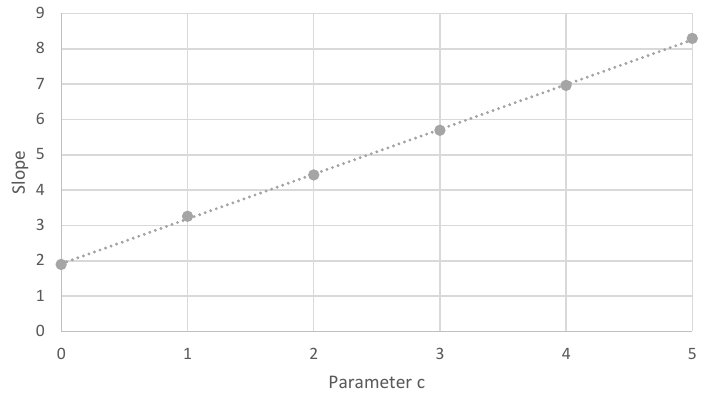
Figure 6. Relation between scaling parameter c and the slope s